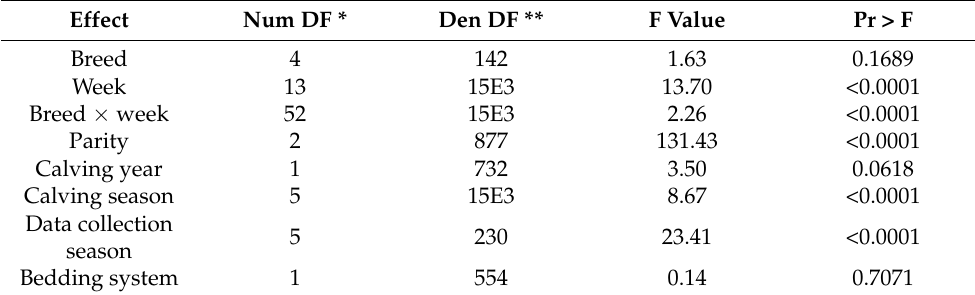
Table A9. Variance analysis results for the variable energy corrected milk yield